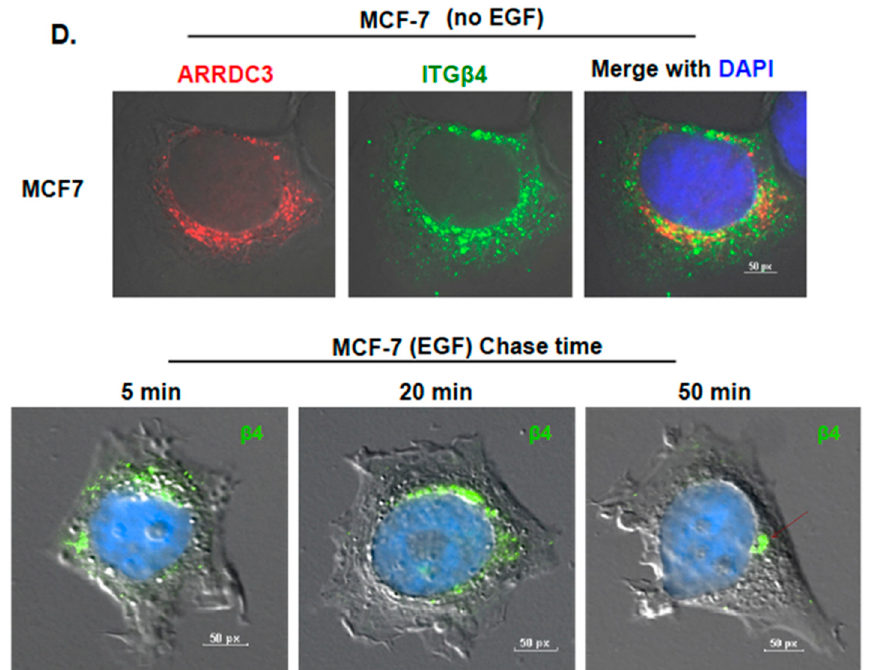
Figure 2. Inhibition of ITG β 4 recycling is linked to ARRDC3 dependent ubiquitination. ( A ) MDA-MB-231 and MCF-7 cells were treated with 30 µ g/mL of cycloheximide (CHX) for the indicated times. The levels of ITG β 4 and ARRDC3 were detected by immunoblotting (IB) analysis. β -Actin was used as a loading control. ( B ) Ubiquitination of ITG β 4 in MDA-MB 231 and MCF-7 cells transfected with HA-Ub was detected by immunoprecipitation (IP) with ITG β 4 antibody and IB with HA antibody. ( C ) MDA-MB-231 parental and GFP or GFP-ARRDC3 expressing MDA-MB-231 cells were co-transfected with HA-Ub and either ITG β 4-Myc or Myc-empty vector. IP was performed with Myc and HA trap beads. Ubiquitination was detected by IB with HA antibody. Input; whole cell lysate. All representative images were obtained from three independent experiments. ( D ) MCF-7 cells were plated on cover glasses and stained with anti-ARRDC3 (red) and anti-ITG β 4 (green) antibodies, followed by mounting with DAPI (blue) (upper panel). Immunofluorescence-based ITG β 4 recycling assay were performed in MCF-7 cells as described in materials and methods. Immunofluorescence signals of ITG β 4 (green) were captured by a fluorescence microscope with DIC optic (lower panel). Scale bar: 50 µ m. Representative images were selected from three independent experiments.